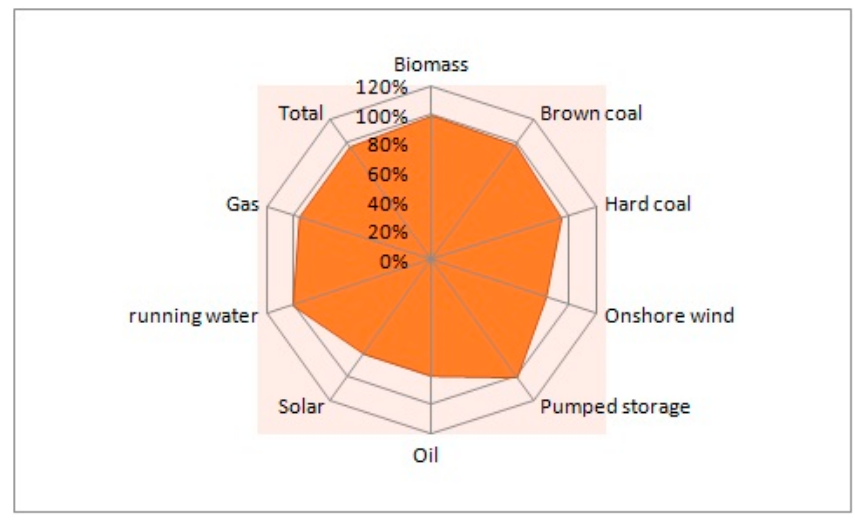
Figure 29. Market value factors in Germany (2020). [76].